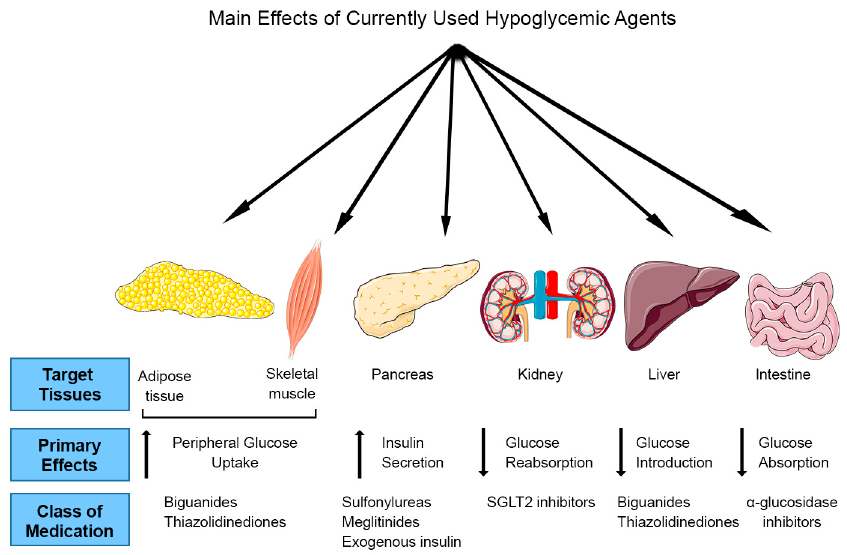
Figure 1. Target tissues and mechanism of action of current anti-diabetic drugs.